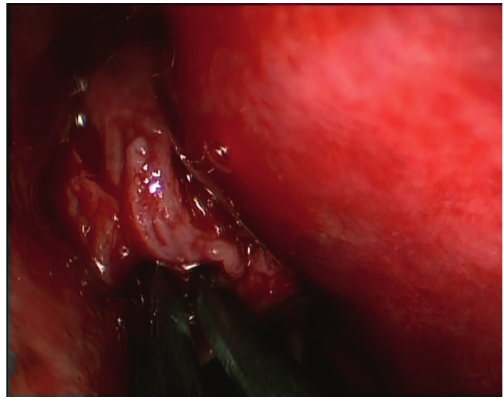
Figure 12: Endoscopic view showing two layers of free graft for skull base